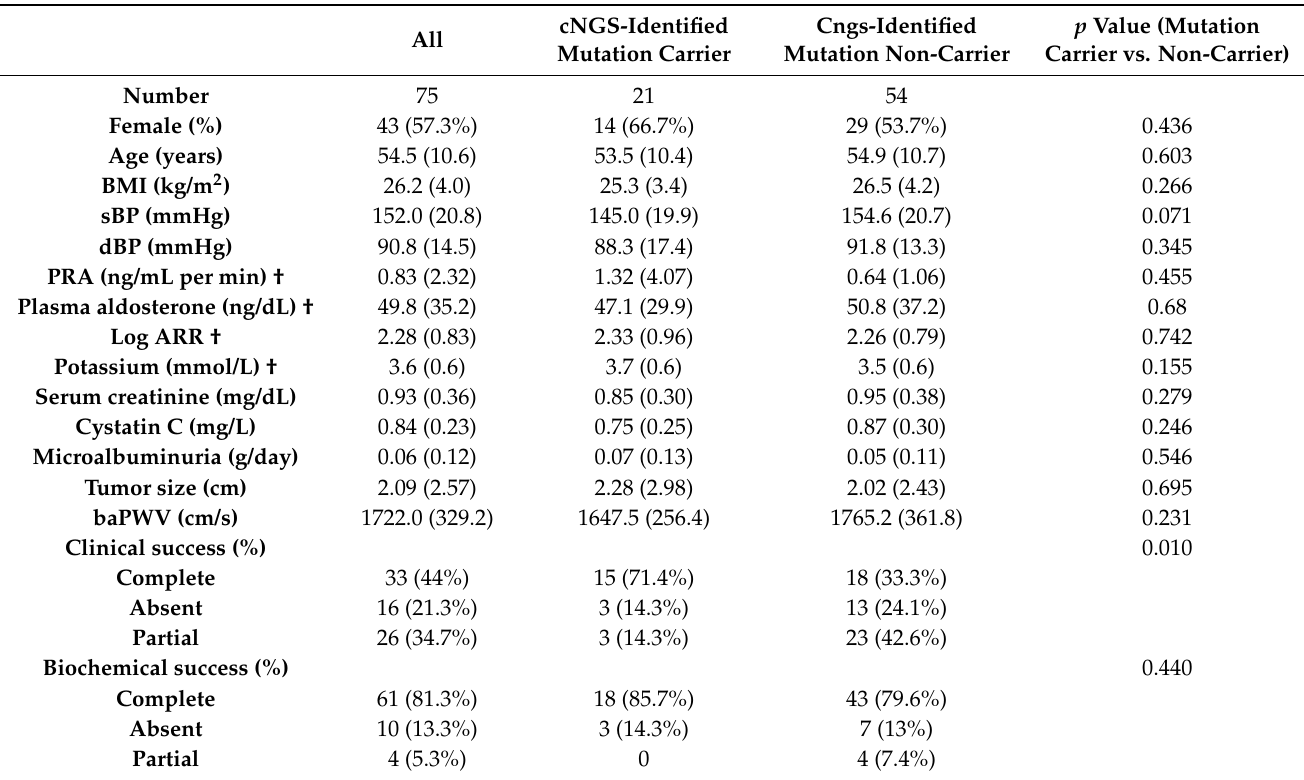
Table 2. Clinical characteristics of unilateral primary aldosteronism patients with respect to NGS-identified mutations.